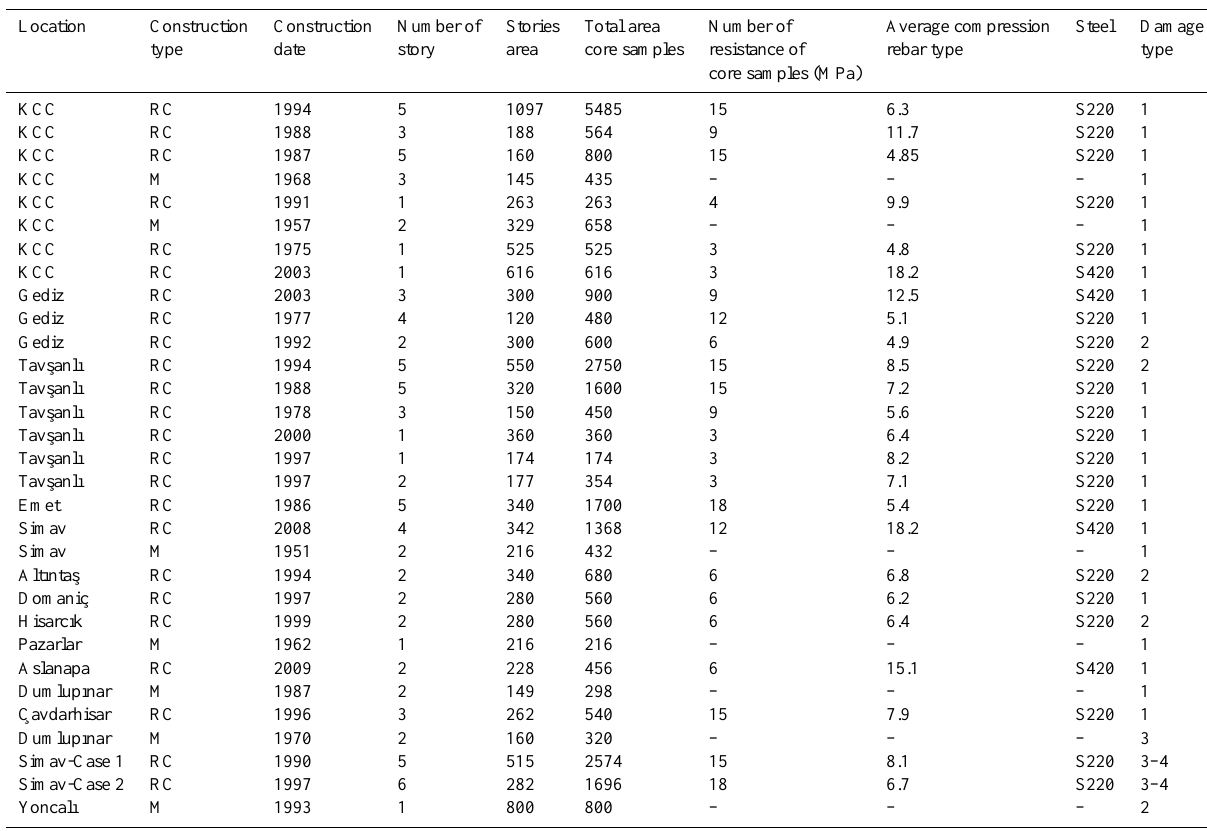
Table 2. Description of government buildings surveyed by the team. Location